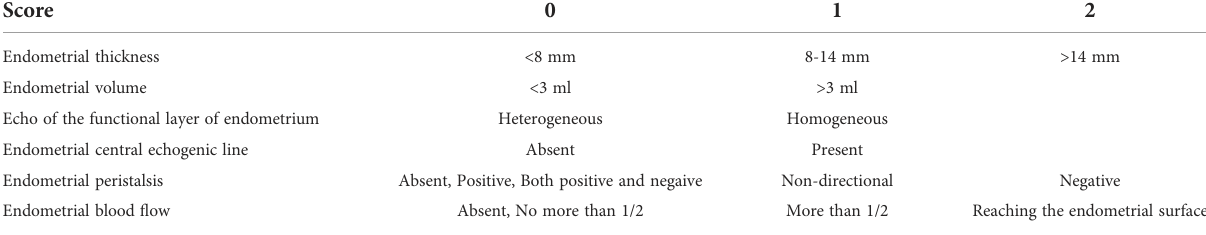
TABLE 3 Endometrial receptivity scoring system.